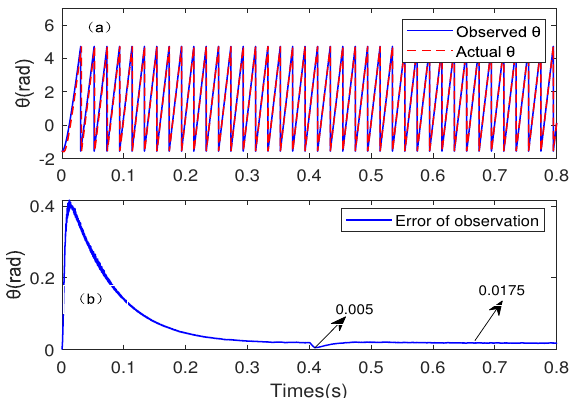
Figure 13. The speed response of PI regulator under 1000 r/min. ( a ) Observed speed and actual speed. ( b ) Estimation error curve.